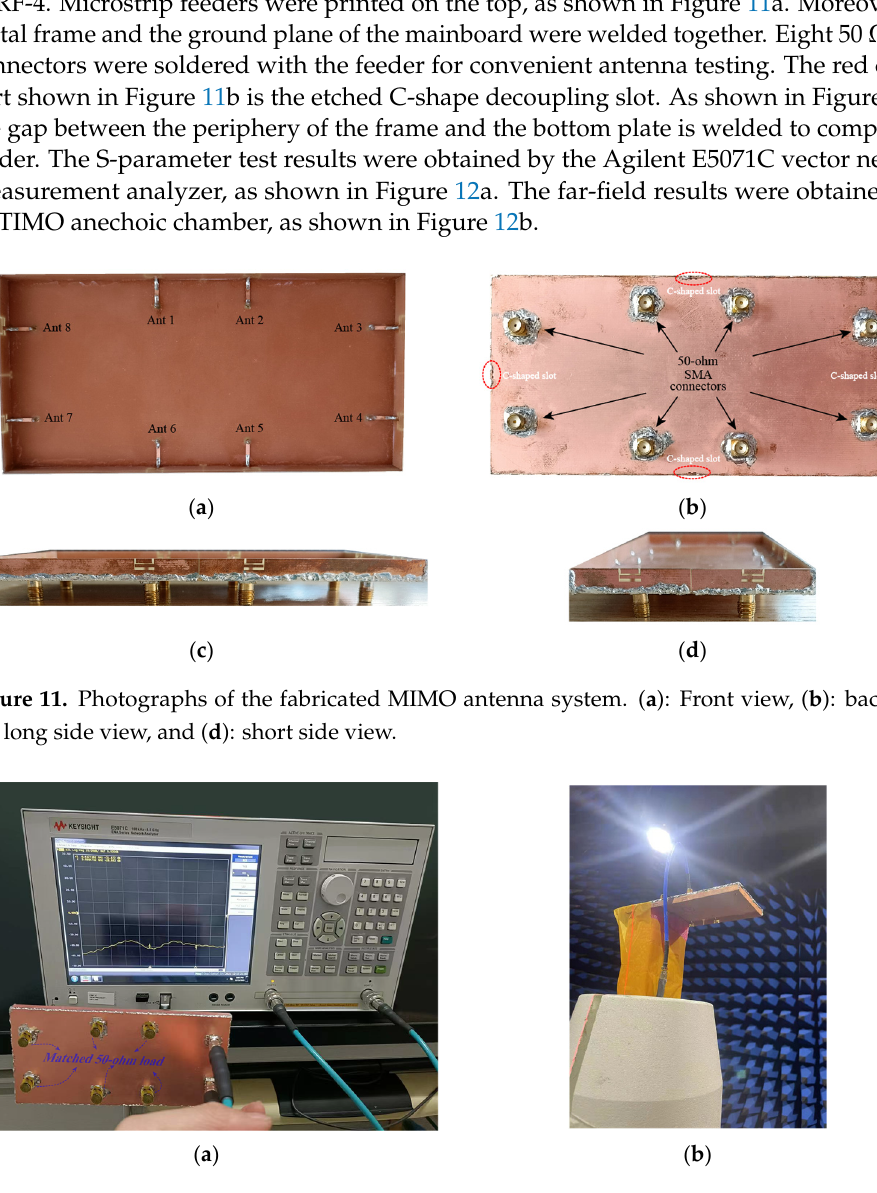
Figure 10. Transmission coefficients of MIMO antenna systems with decoupling.